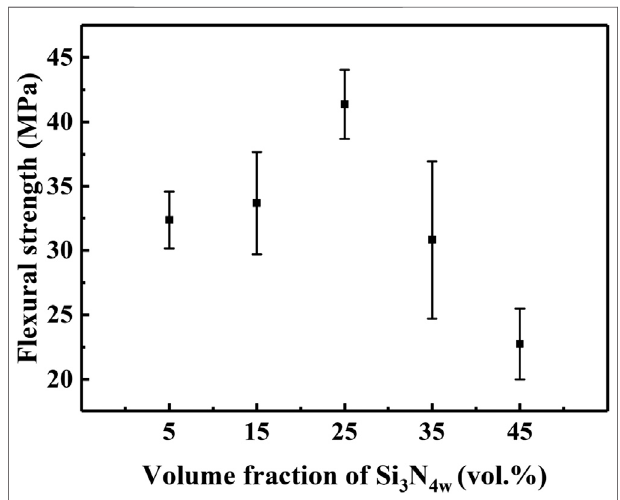
FIGURE 10 | Flexural strength of the fi ve kinds of Si 3 N 4w /Si 3 N 4 .